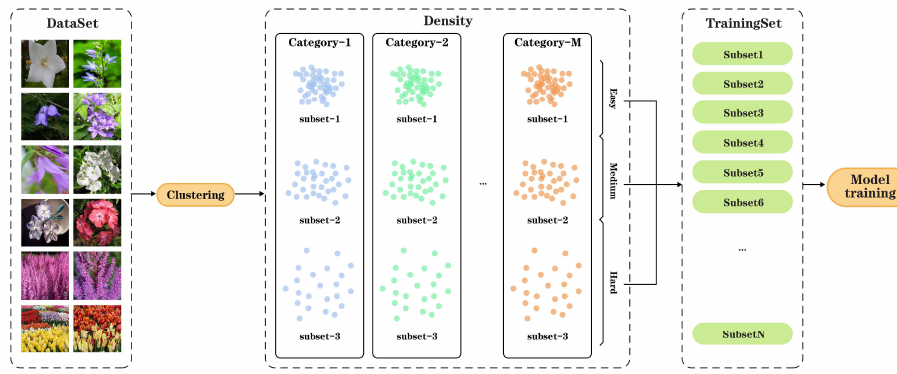
Figure 6. Visualization of difficulty evaluator based on the clustering algorithm.